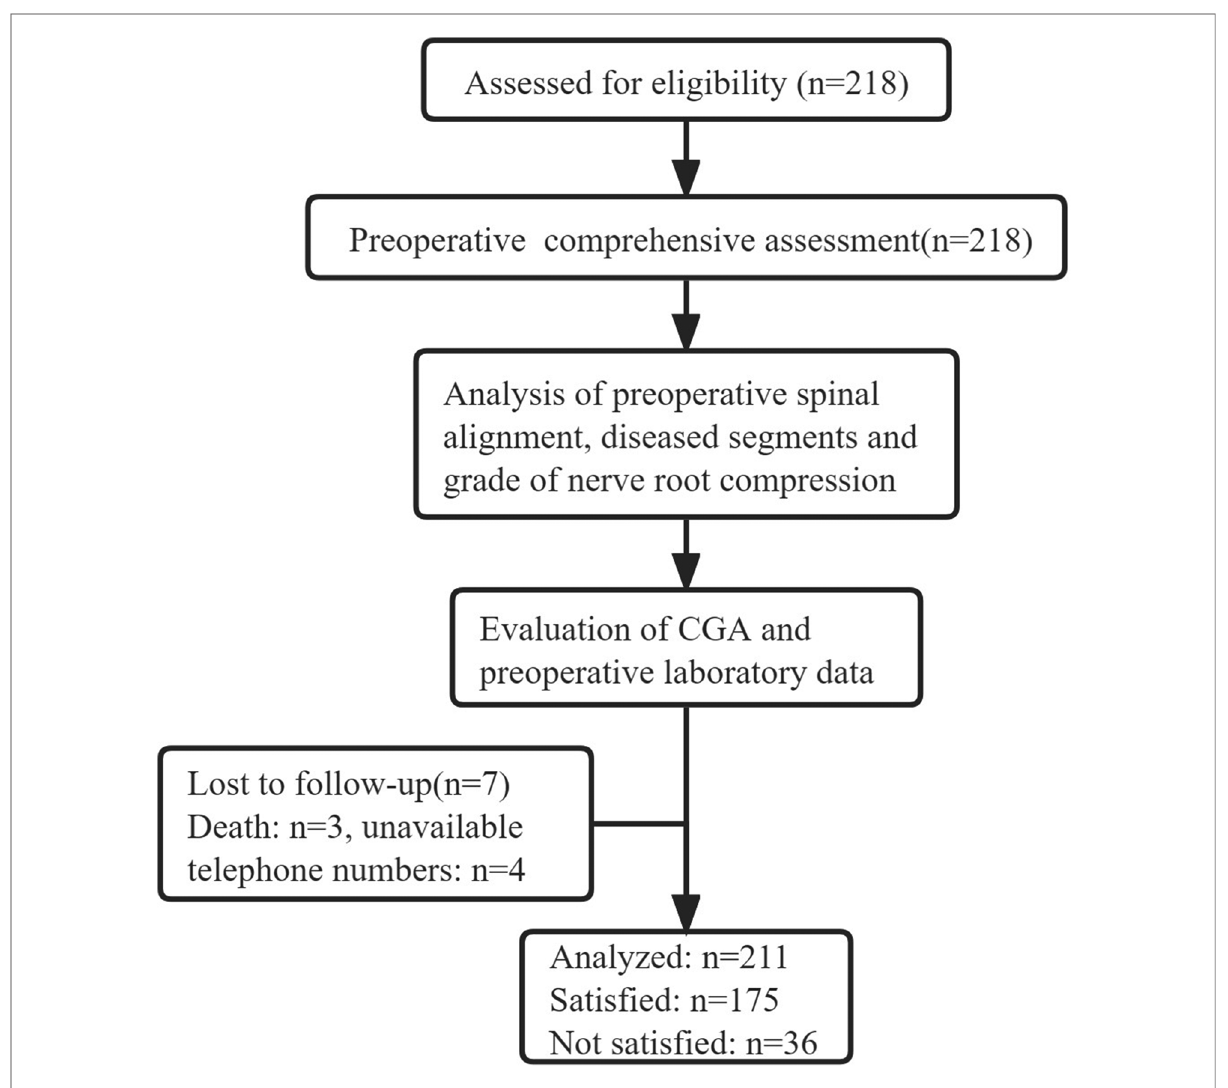
FIGURE 1 Flow chart of study